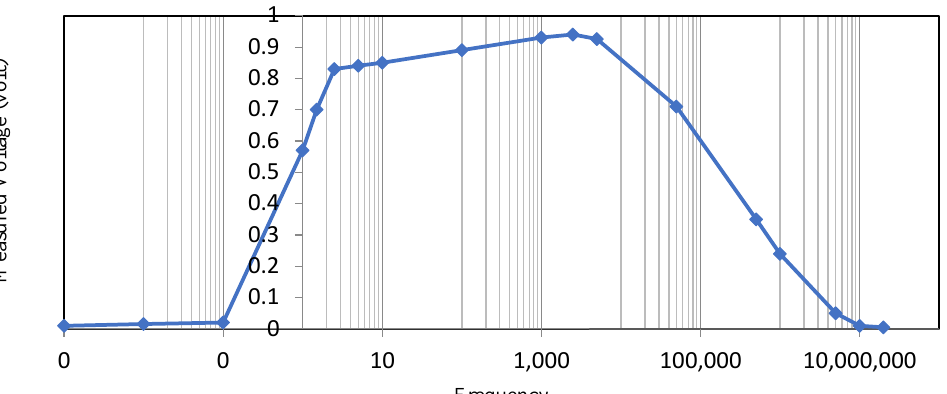
Figure 5. Measured alternating voltage (AV) versus frequency between the heads of the concrete sensor at constant input alternating voltage (AV).